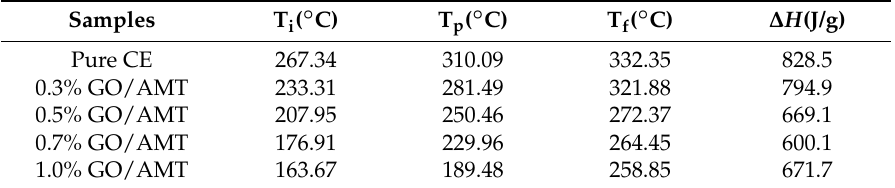
Figure 4. Differential scanning calorimetry (DSC) curves of GO/AMT-CE composites with different GO-AMT contents. Table 1. Sample formulation and Differential scanning calorimetry (DSC) date of various graphene